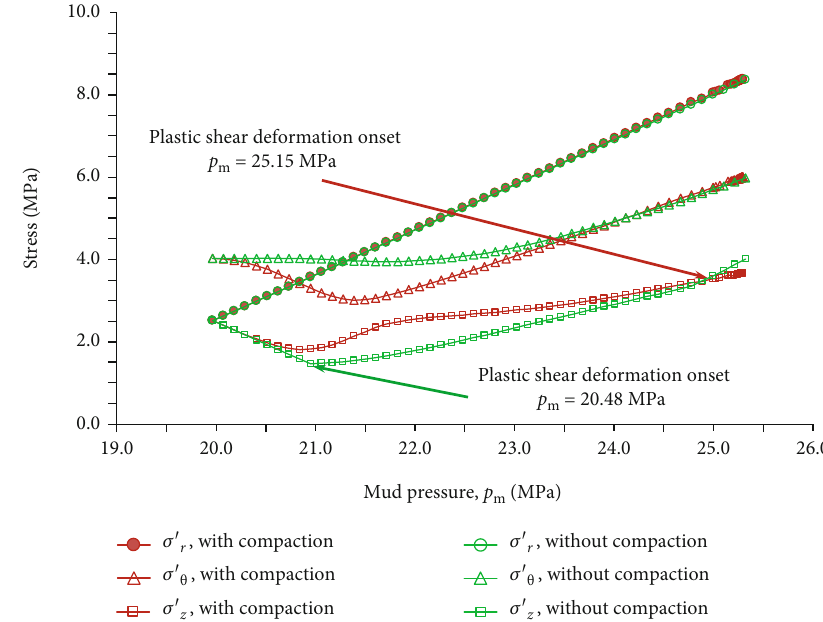
Figure 12: E ff ective stress evolution at a point on the wellbore surface during the drilling process (perfect fl ow barrier and p